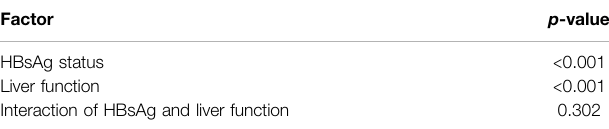
TABLE 4 | Variance analysis of HBsAg, liver function, and their interaction on the onset of GDM.